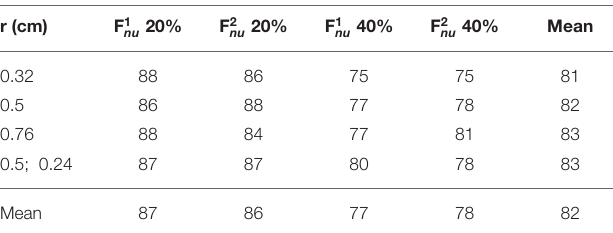
TABLE 2 | Values of the threshold D th expressed as percentage of D A , max